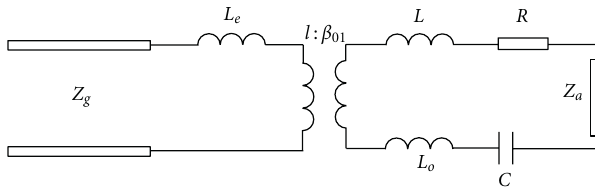
Figure 6: Simplification of equivalent circuit in Figure